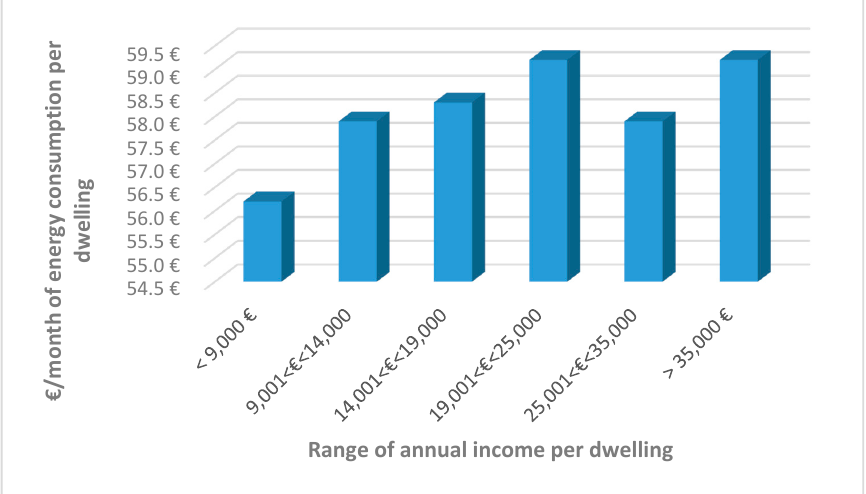
Figure 11. Monthly energy expenditure in €/month per household versus annual income levels: Building A.